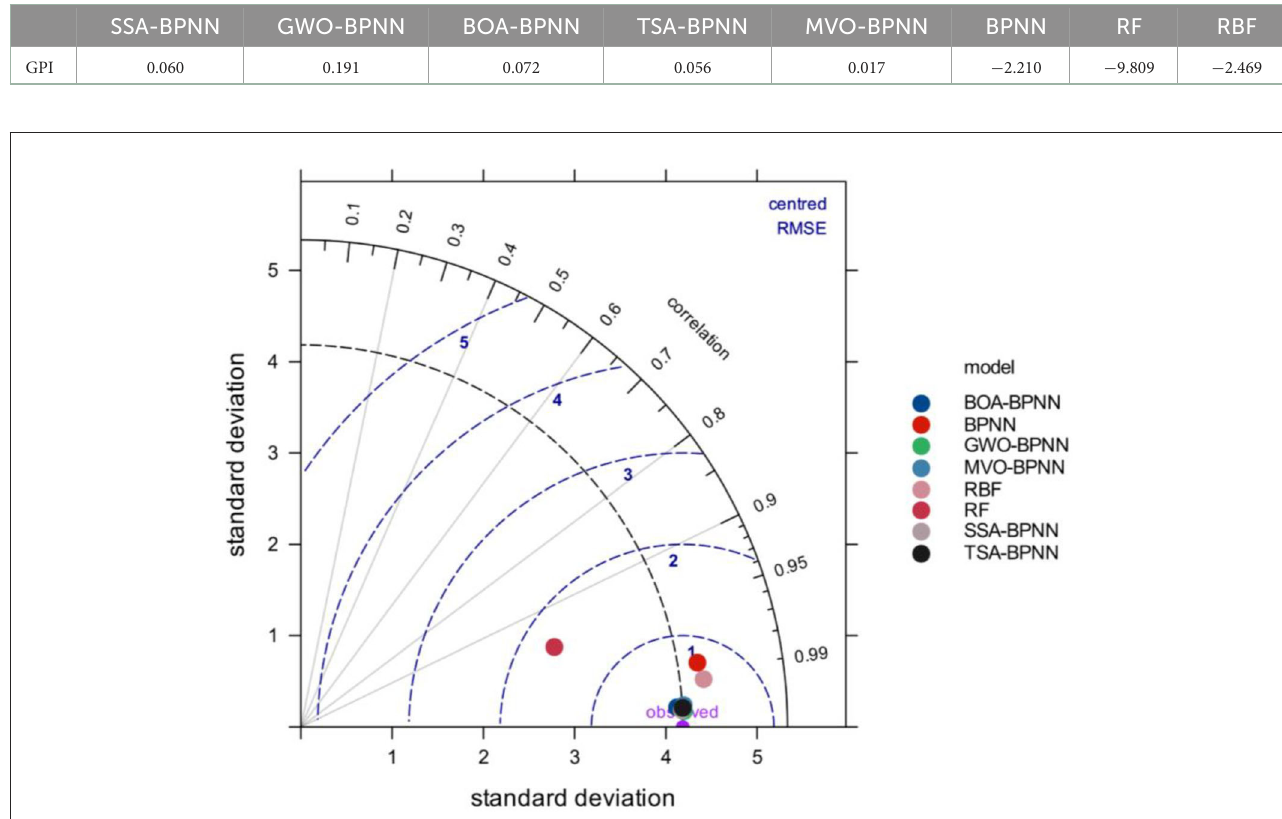
FIGURE8 Model performance comparison in Taylor